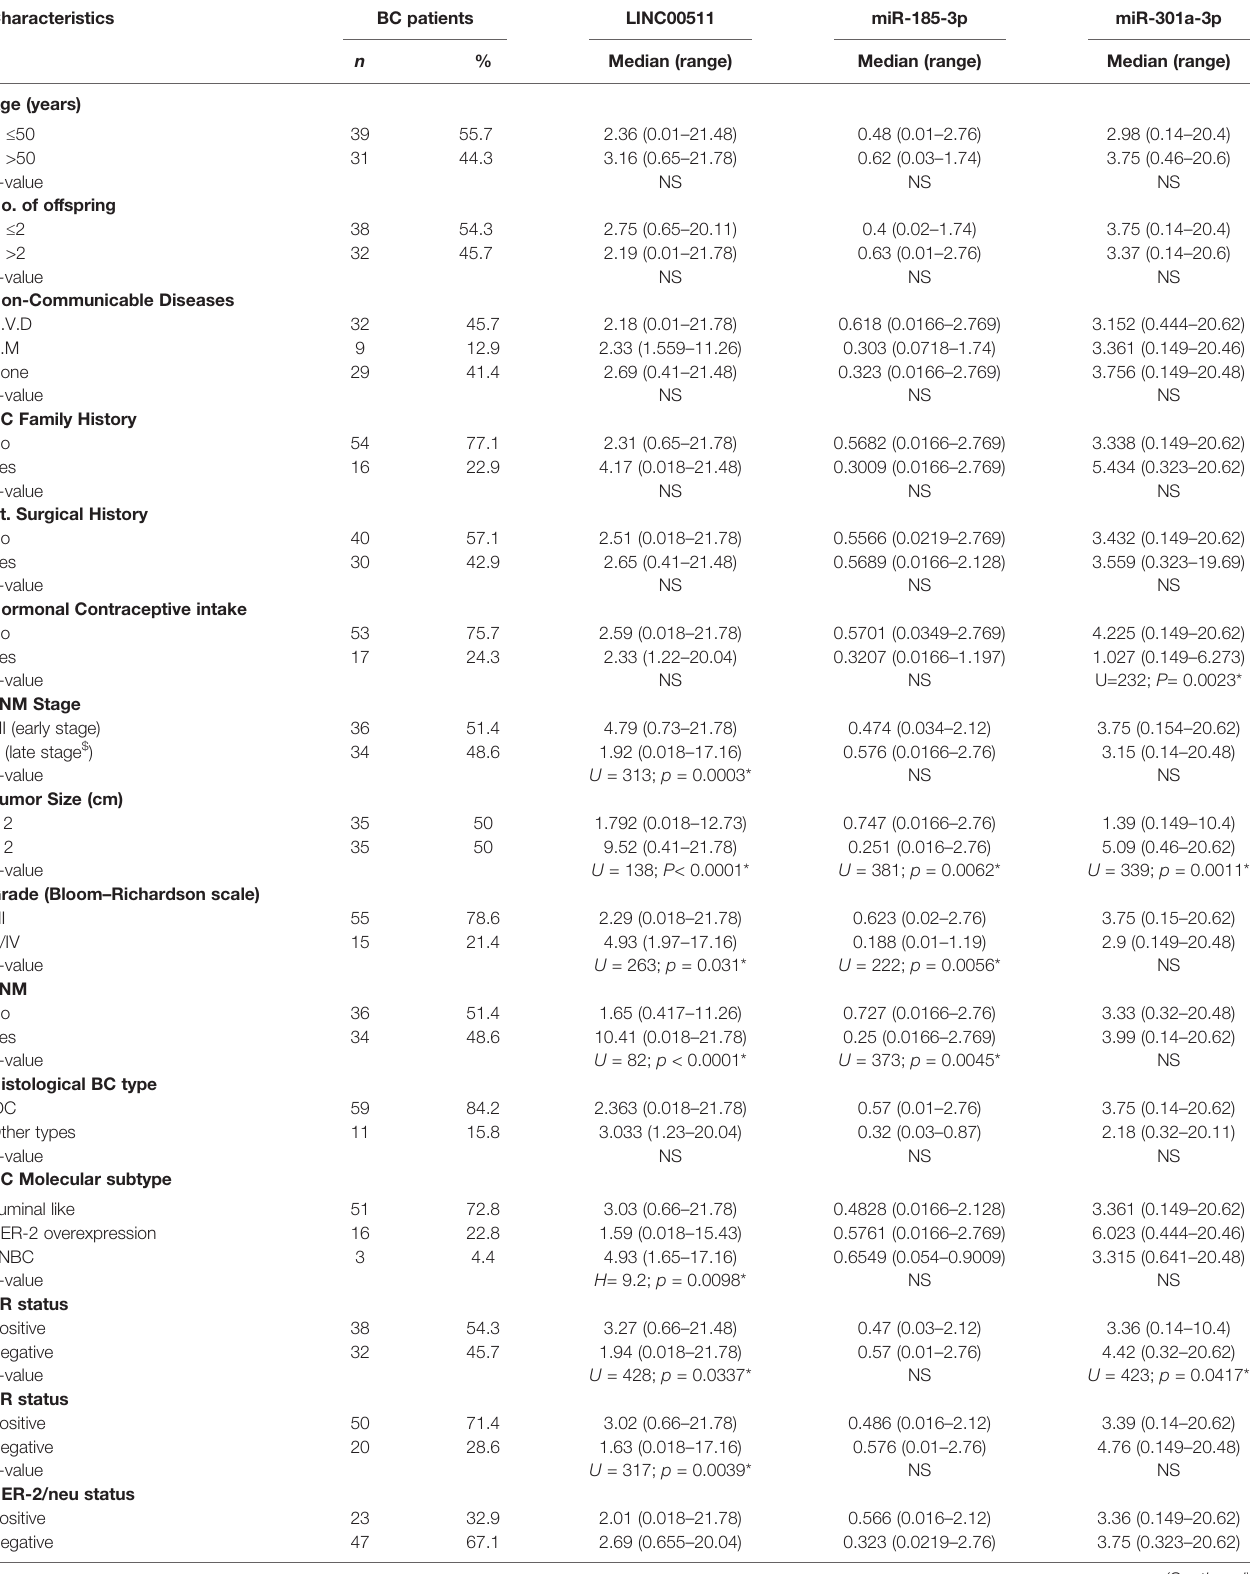
TABLE 5 | Expression levels of LINC00511, miR-185-3p, and miR-301a-3p in BC patient ( n = 70) strati fi ed group/subgroups.